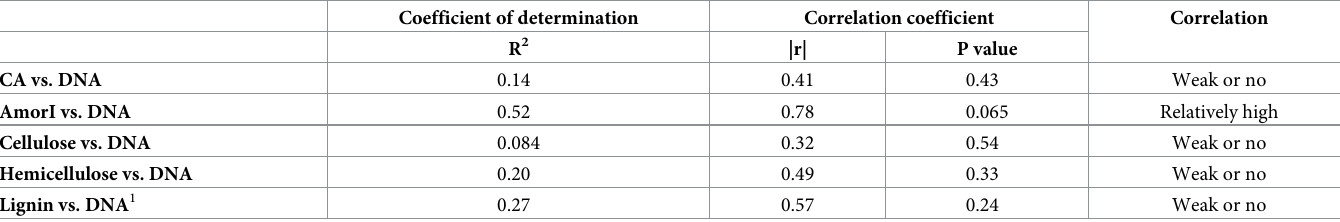
Table 5. Degree of linear fitting and correlation among the extracted DNA, cellulose, hemicellulose, lignin, AmorI, and CA in the